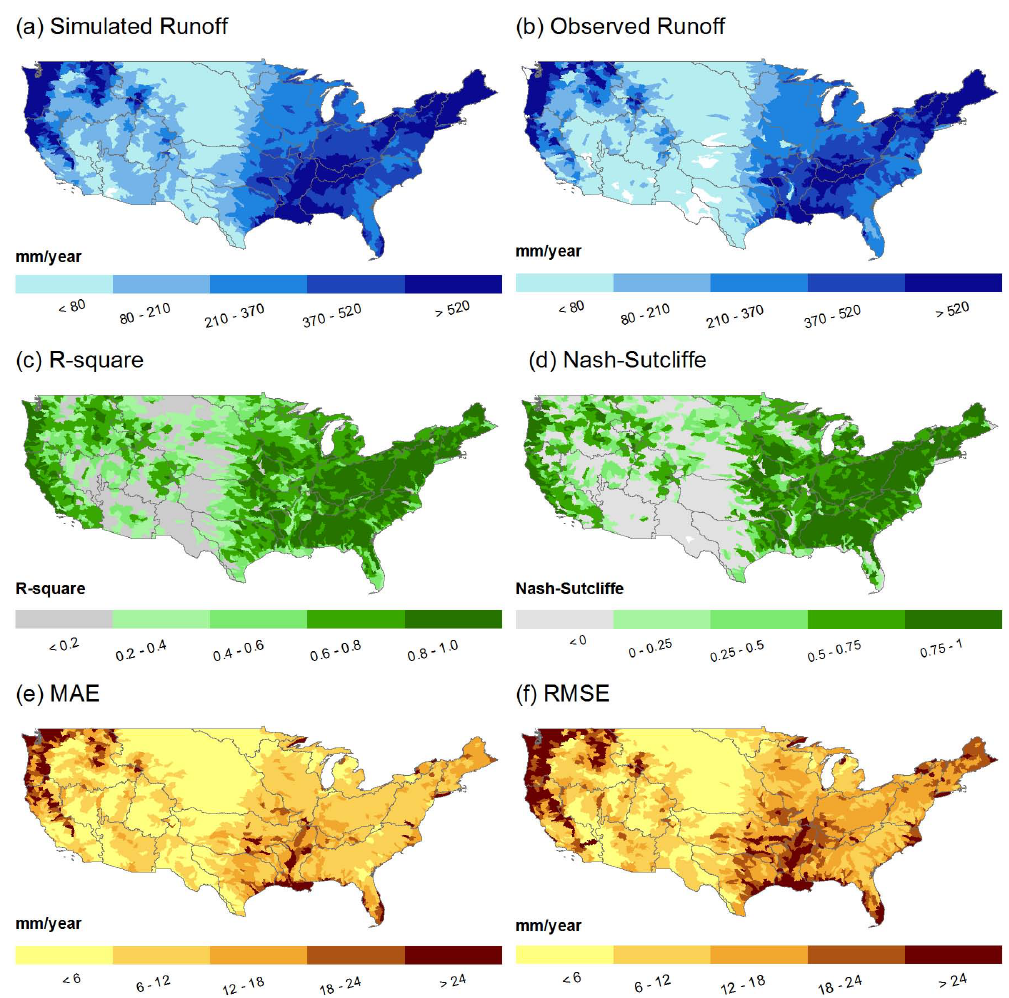
Fig. 12. Performance of calibrated VIC model at various HUC8s in the conterminous US.